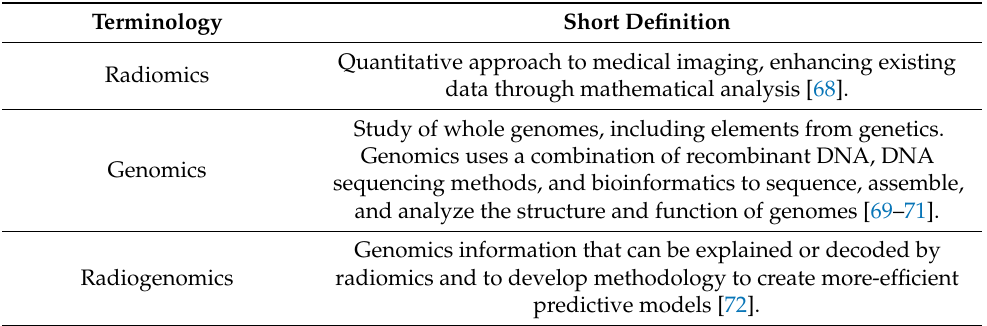
Table 1. Short definitions for specific medical